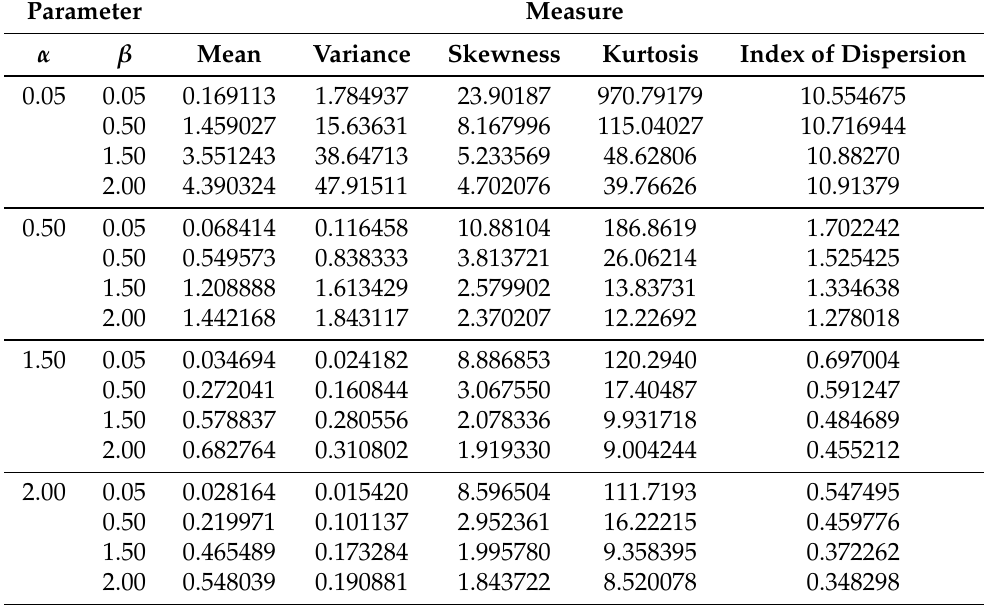
Table 1. Some descriptive statistics of the EBuH